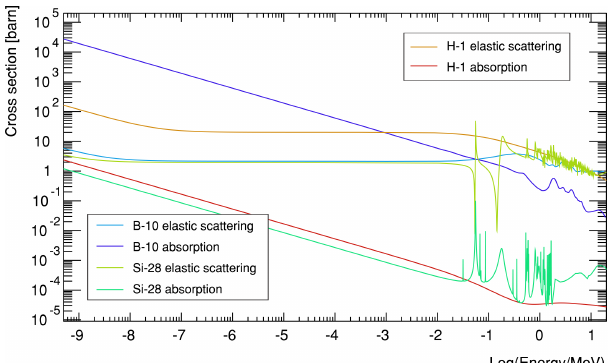
Figure 3. Examples of cross sections for the light isotopes hydro- gen, an efficient moderator; boron as an efficient absorber; and sil- icon, which can be considered nearly transparent, from the ENDF library from thermal energies ranging to several